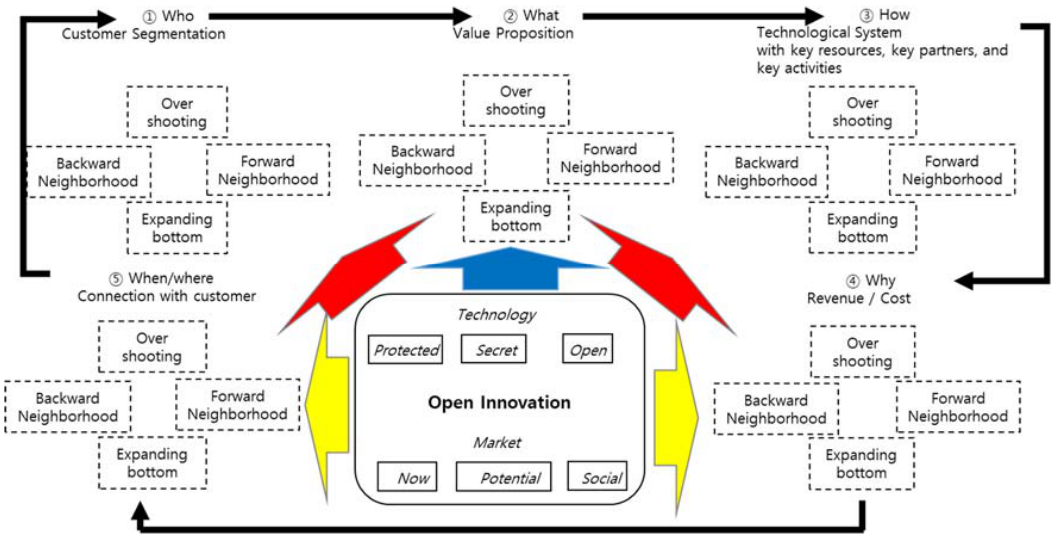
Figure 7. Open innovation as the engine of business model innovation.